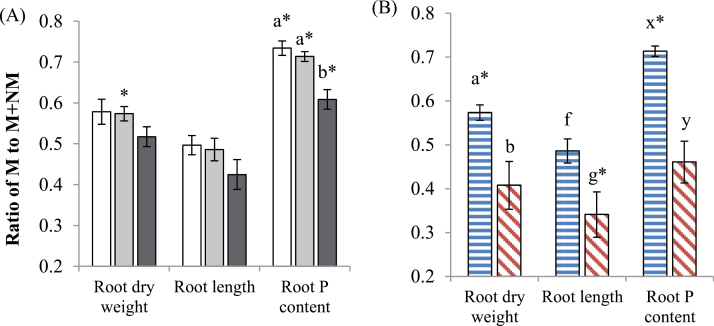
The distribution of resources between colonized and non-colonized root halves (i.e. NM,M pots) was calculated as the ratios of the colonized pot (M) to the total (NM+M). Ratios for root dry weight, length, and P content in (A) wild-type plants at three soil P additions: 0 (white bars), 20 (grey bars), and 50 (black bars) mg P kg–1, and in (B) the wild type (horizontal bars) and mtpt4 mutant (diagonal bars) at P20 only. Values are the mean ±standard error, n=5. Means followed by the same letter were not significantly different at the P<0.05 level (Tukey’s HSD). For (B) different sets of letters (ab, fg, xy) indicate a significant difference (at the P<0.05 level, Student’s t-test) between genotypes, for different response variables, respectively. Asterisk denotes values that are significantly different from 0.5. (This figure is available in colour at JXB online.)